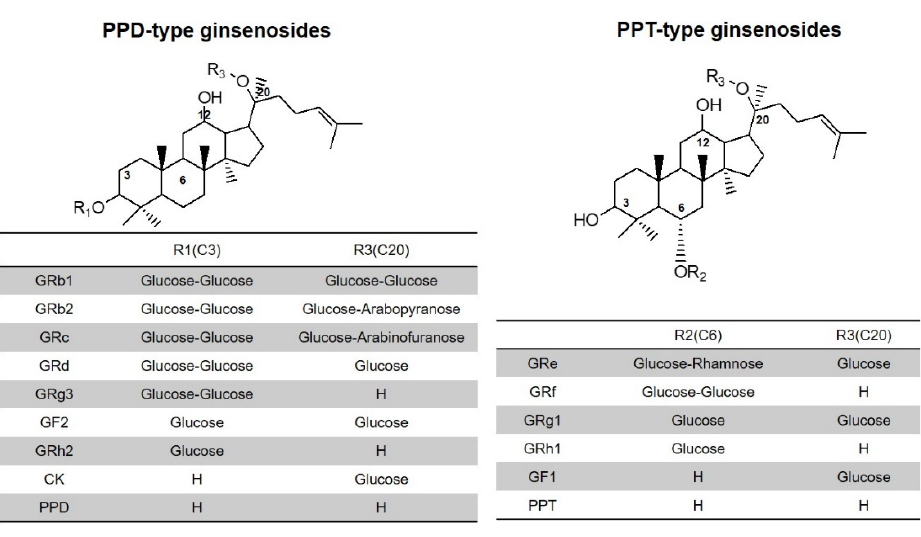
Figure 1. Structure of 20( S )-protopanaxadiol- and 20( S )-protopanaxatriol-type ginsenosides. Com- pound K, CK; protopanaxadiol, PPD; protopanaxatriol, PPT.